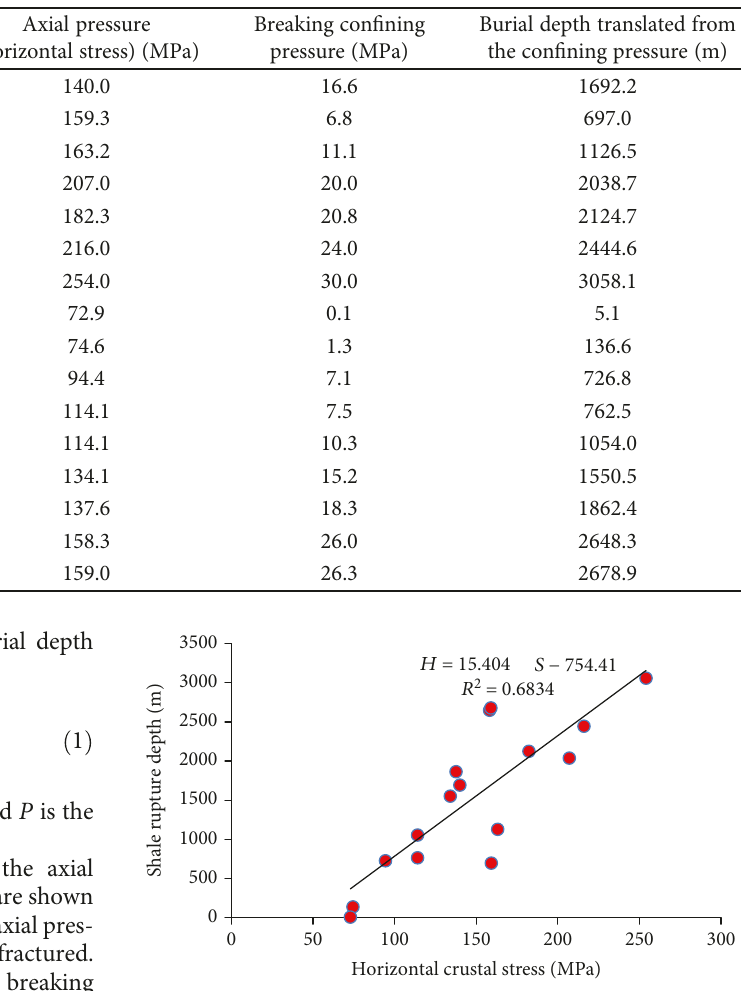
Figure 5: Correlation diagram of the burial depth and the horizontal stress when the shale fractured in the triaxial unloading tests. See Figure 1 for the well